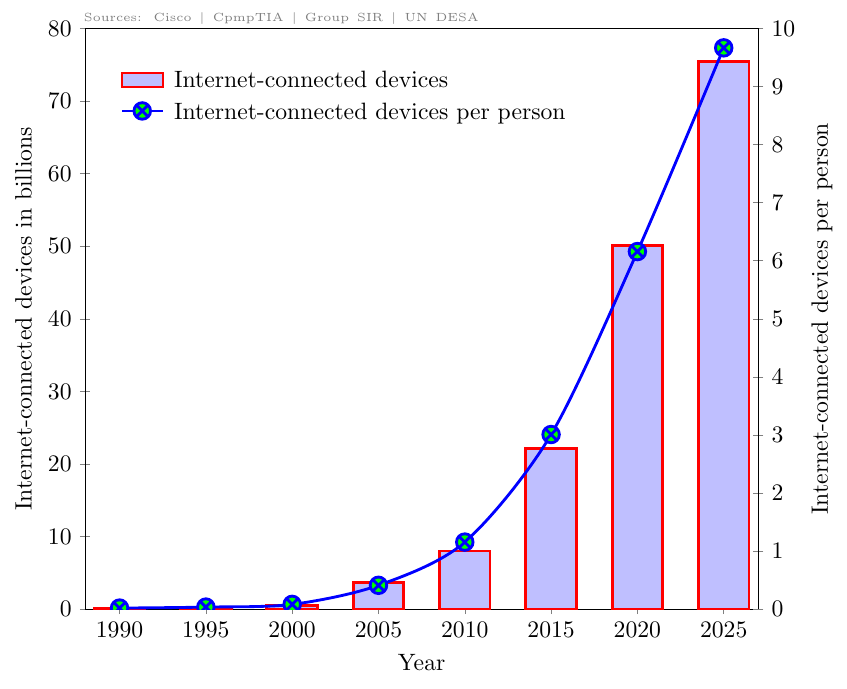
Figure 1. Internet-connected devices across the